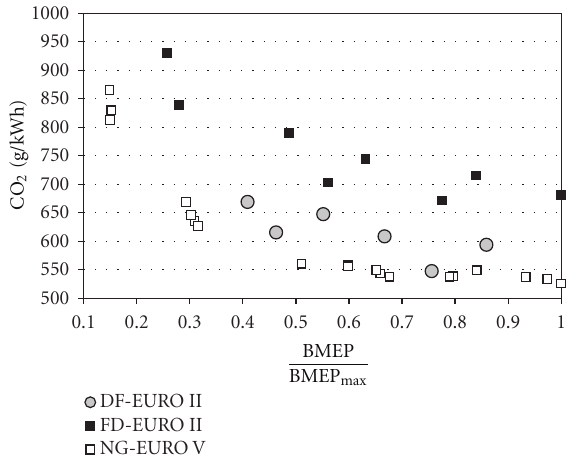
Figure 8: CO 2 emission for DF, FD, and full NG engines measured in the condition of Figure 4.